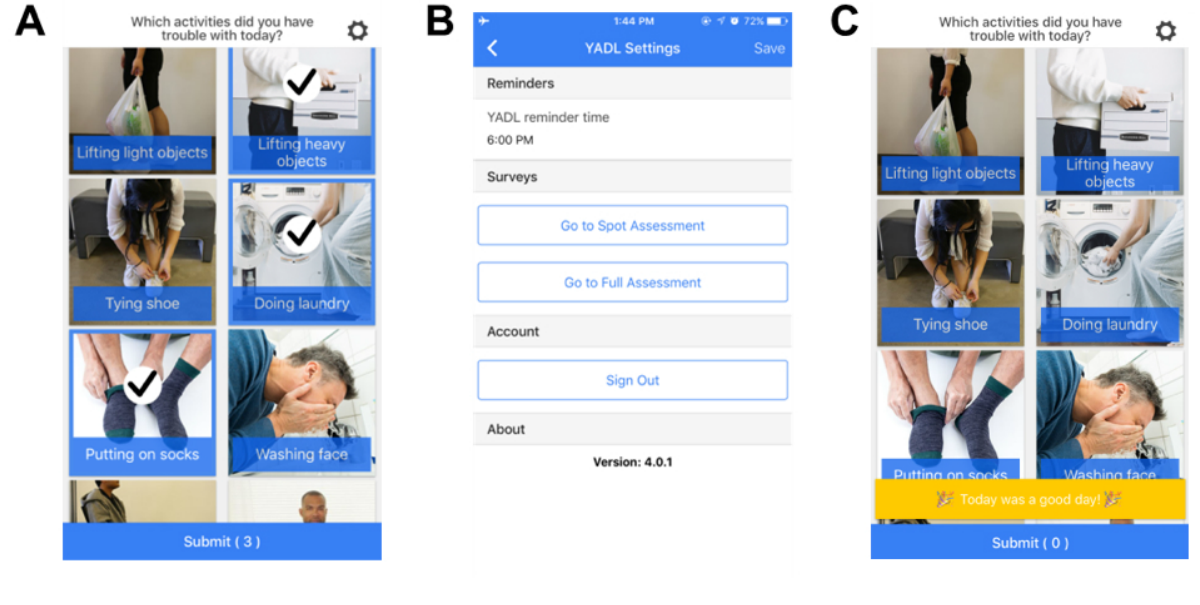
Figure 1. Screenshots from the Your Activities of Daily Living app: (A) daily assessment, (B) daily assessment reminders, and (C) when there was nothing to report, patients selected “Today was a good